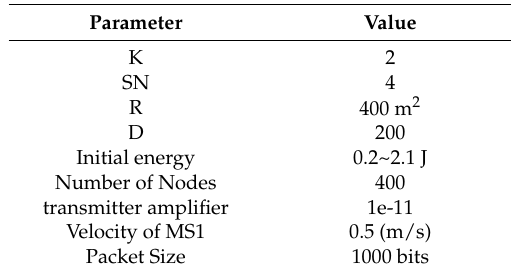
Table 3. Parameters used in CM2V2.